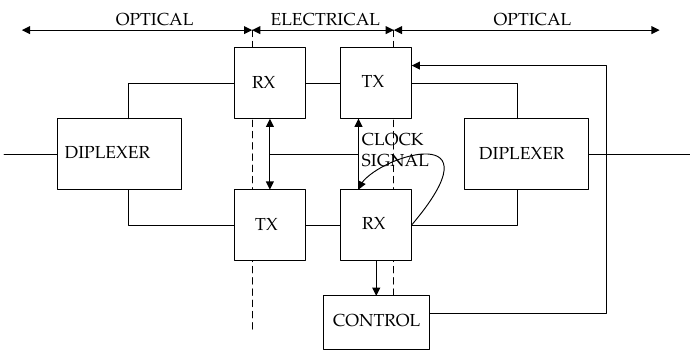
Figure 2. Principle of 3R in a reach extended passive optical network (RE-PON).